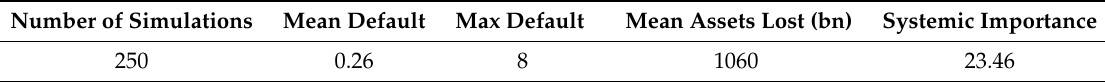
Table 3. Greece’s interconnectedness (interconn.).